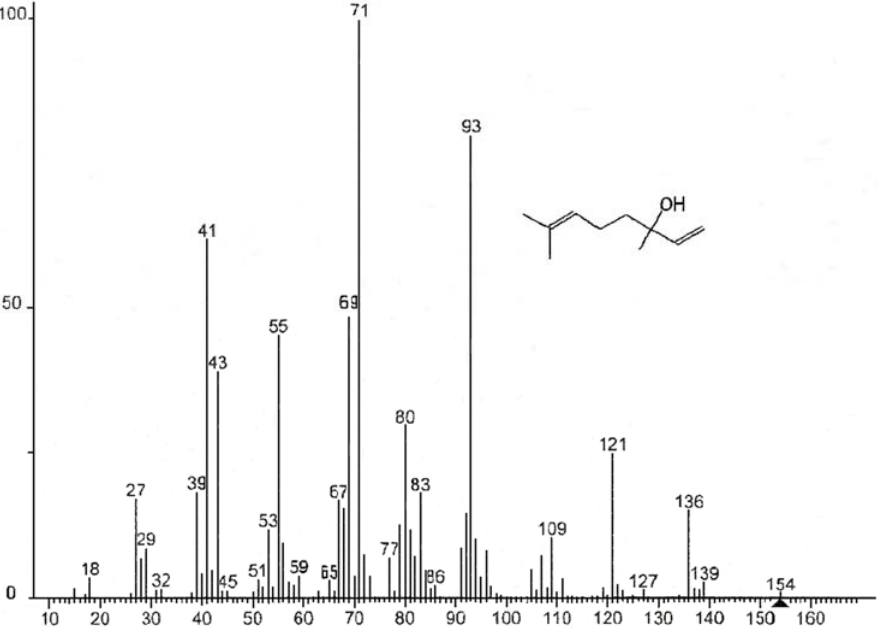
Figure 3. Mass spectra of linalool.